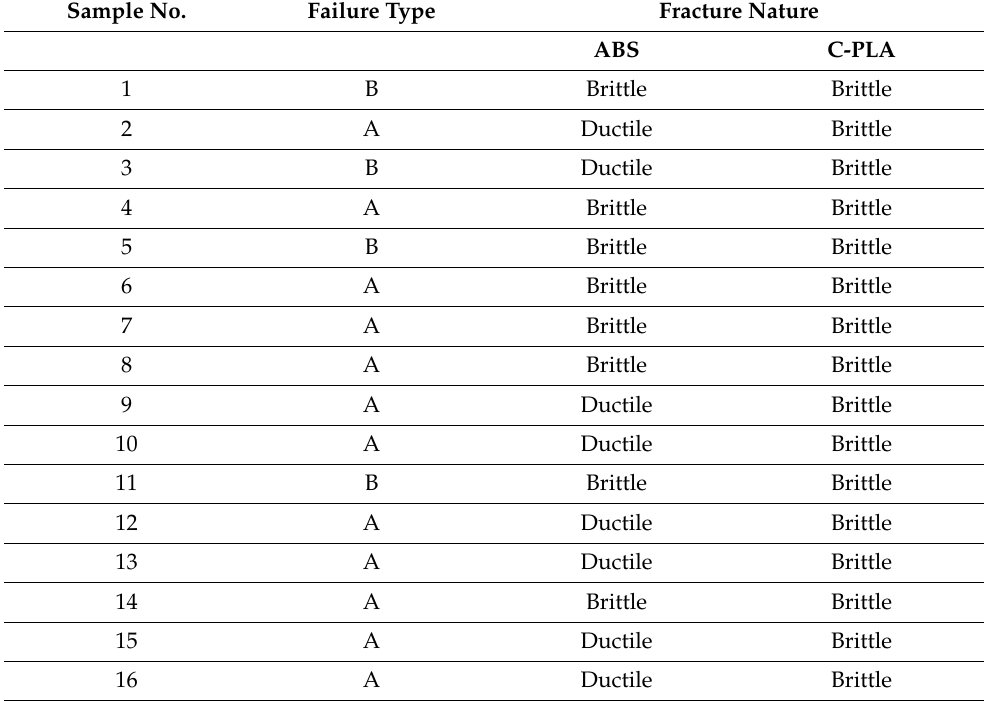
Figure 7. Fractures in C-PLA/ABS hybrid composite: ( a ) Both laminates fractured without any delamination; ( b ) Delamina- tion of boundary wall; ( c ) Brittle fracture in C-PLA lamina with RA of 0 ◦ /90 ◦ and 45 ◦ / − 45 ◦ ; ( d ) Brittle fracture in ABS lamina with RA of 0 ◦ /90 ◦ ; ( e ) Ductile fracture in ABS lamina with RA of 45 ◦ / − 45 ◦ . Table 8. Facture type and nature of samples.